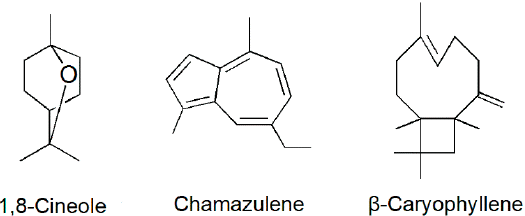
Figure 1. Chemical structures of the three most abundant compounds isolated from the essential oil.